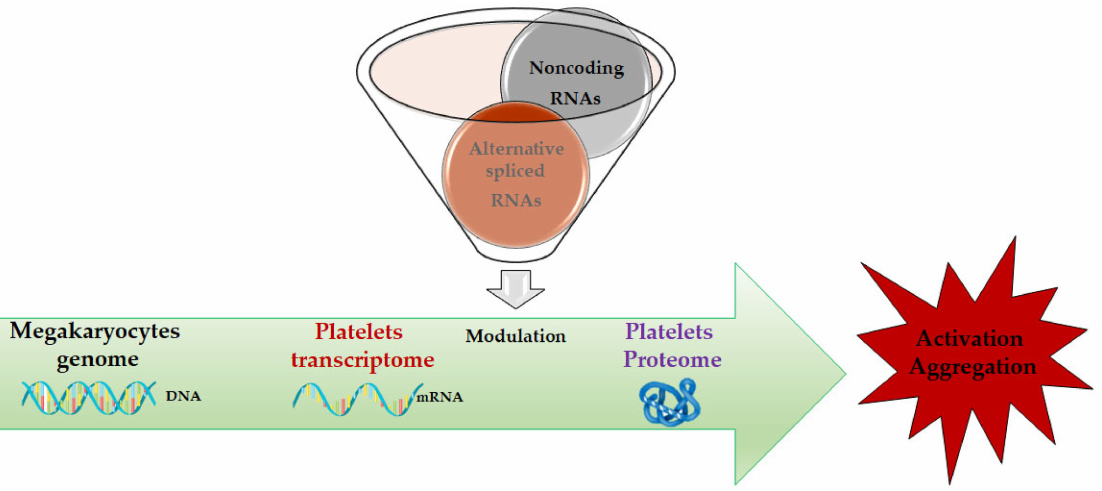
Figure 2. The central dogma of biology in platelets: from megakaryocyte genome to platelet pro- teome via platelet transcriptome modulation. The focus is on noncoding RNAs and alternatively spliced